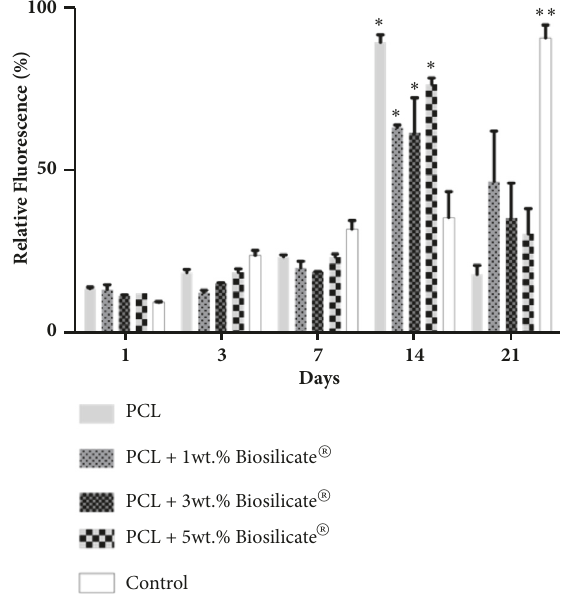
Figure 6: Cell viability of the scaffolds. Each column represents the mean ± SEM(StandardMeanError)betweenthesamples. ∗ n < 0.05 for the scaffolds in comparison with the control; ∗∗ n < 0.05 for the control in comparison with all